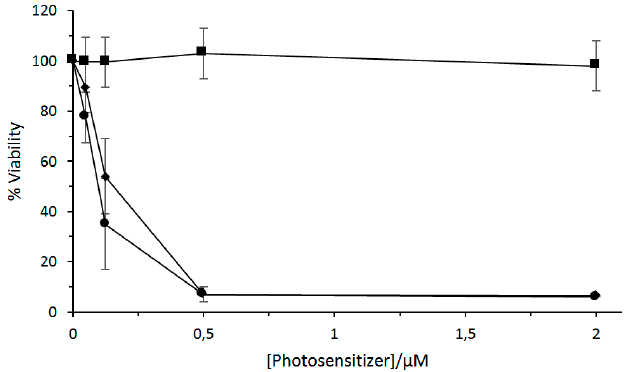
Figure 7. In vitro photocytotoxicity of TMe- β -CD-Si IV Pc ( ♦ ), TPPS 4 ( ■ ), and the 1:1 host–guest complex ( ● ) against HT29 cells under red light illumination ( λ > 610 nm, total fluence = 48 J/cm 2 ). Adapted from Leng; Choi; Lo; Ng [122].